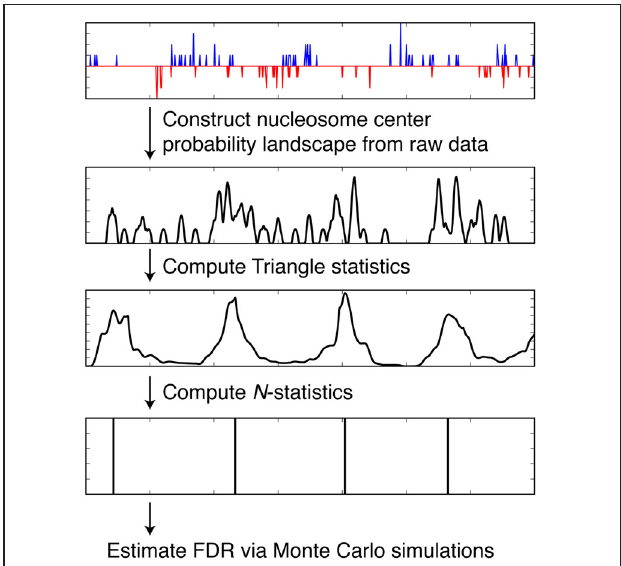
FIGURE 4 | Steps taken by NSeq during nucleosome detection. NSeq runs through the steps summarized here to extract nucleosome centers from raw sequencing data. The plots in black representatively depict quantities computed across the genome.